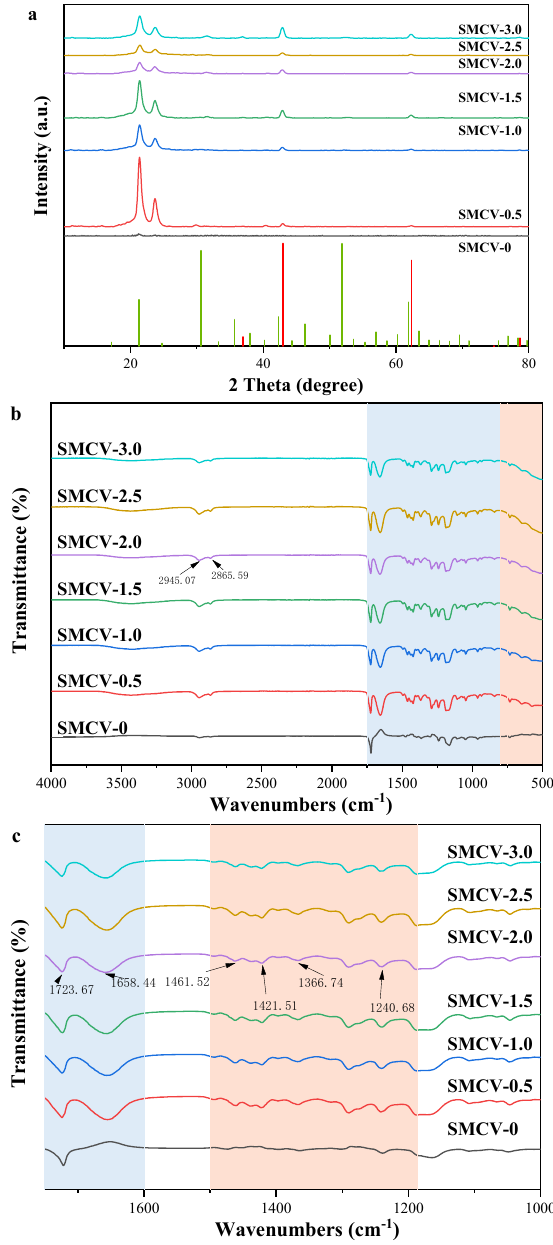
Figure 3. ( a ) XRD pattern of SMCV (SMCV − 0, SMCV − 0.5, SMCV − 1.0, SMCV − 1.5, SMCV − 2.0, SMCV − 2.5, and SMCV − 3.0); ( b ) ATR spectra of SMCV (SMCV − 0, SMCV − 0.5, SMCV ‐ 1.0, SMCV − 1.5. SMCV − 2.0, SMCV − 2.5, and SMCV − 3.0).